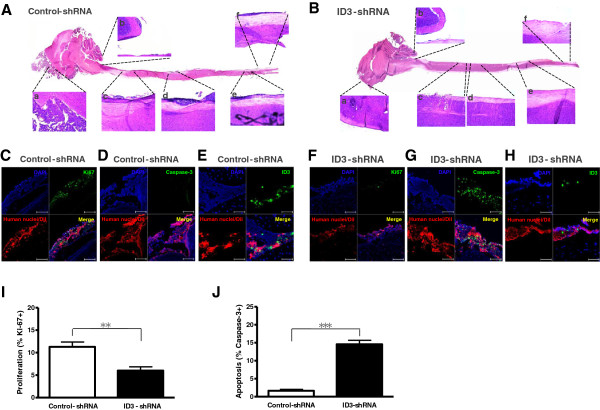
Histological section of mice for evaluation of tumor seeding. (A and B) Representative longitudinal sections of the brains and spinal cords of the mice with D283-control-shRNA or D283-ID3-shRNA (hematoxylin & eosin stain) (1.25×). Inlet figures denote (a) subfrontal area, (b) craniocervical junction (cistern magna) where the tumor cells were first implanted, (c) upper thoracic spinal cord, (d) midthoracic spinal cord, (e) lumbar spinal cord, and (f) conus medullaris (100×). (C and F) Immunofluorescence (IF) staining with anti-Ki-67, a proliferation marker, on the specimen. (D and G) IF staining with anti-caspase-3, an apoptosis marker. Scale bars represent100 μm. (E and H) IF staining with anti-ID3. (I and J) Comparison of the proportions of Ki-67+ cells and caspase-3+ cells.